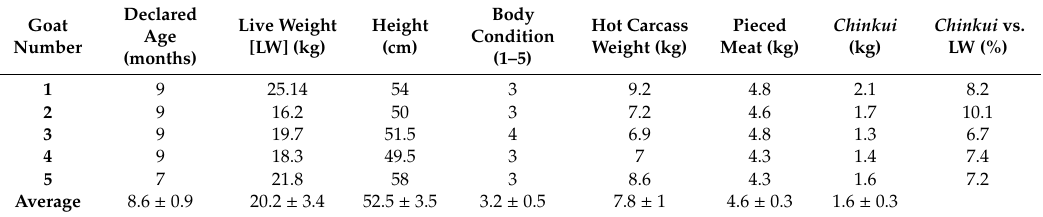
Table 1. Ante mortem, post mortem and chinkui production characteristics recorded through participant